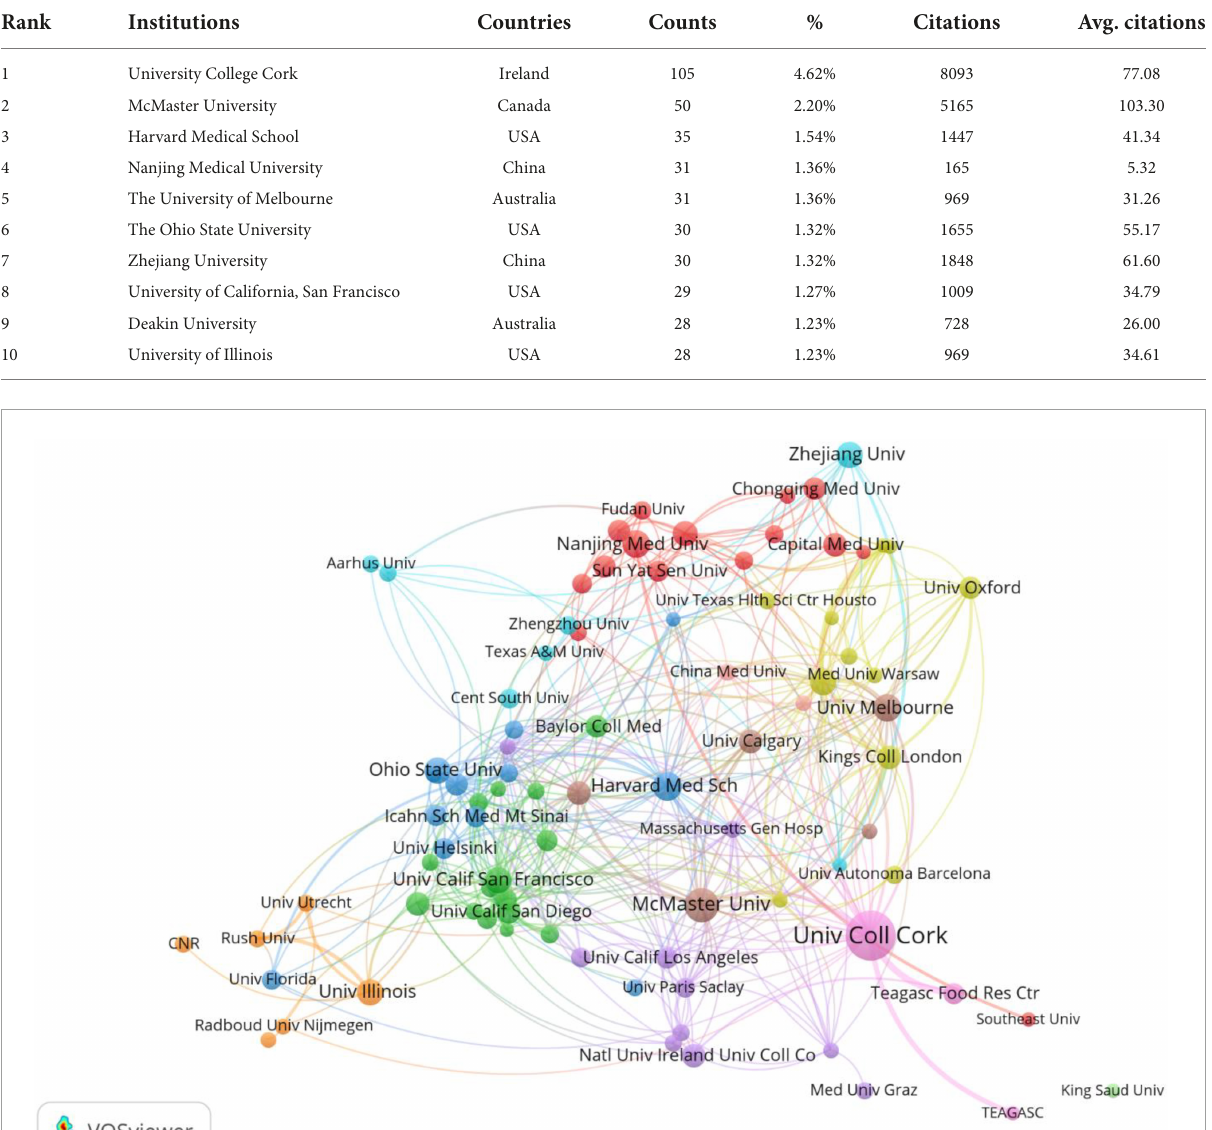
FIGURE3 Cooperation network of institutions to study the gastrointestinal microbiome and neuroscience. Map of institutions’ cooperation showed 87 institutions with a minimum of 10 publications.